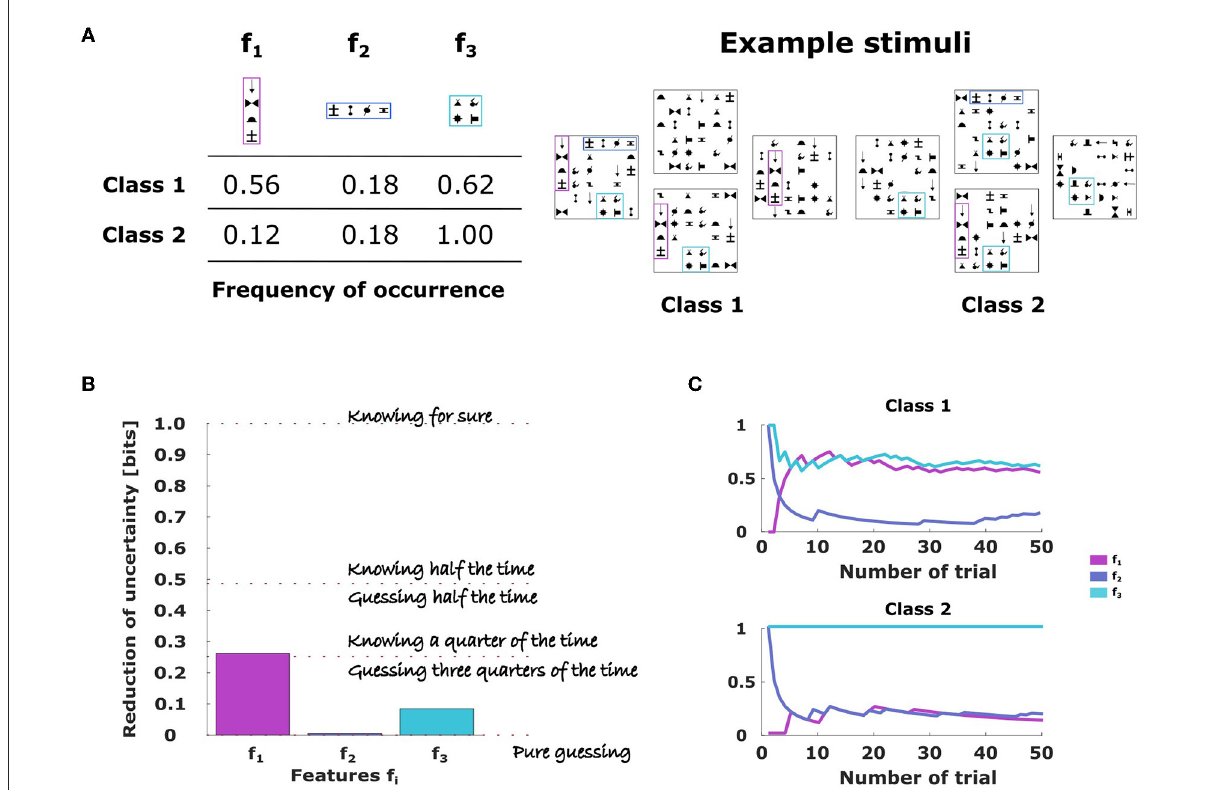
FIGURE1 Binary classification task with three features. (A) Each feature is given by a symbol arrangement labeled f 1 , f 2 , and f 3 and occurs with a certain probability for stimuli of each stimulus class, shown in the Table 1. Examples of combined stimulus pattern belonging to class 1 or class 2 are shown on the right. Crucially, subjects did not know the class membership, but had to infer it from the presence and absence of stimulus features. (B) The amount of information the different features carry about the stimulus class is measured by the mutual information: a value of 1 bit implies that class membership can be surely inferred, a value of 0 means that the feature provides no information and the decision-maker has to guess. A value in between implies that the feature provides some information and the subject can engage in some educated guessing. (C) Temporal evolution of the empirical frequencies of the different stimulus features. Empirical frequencies can be reliably estimated after less than 10